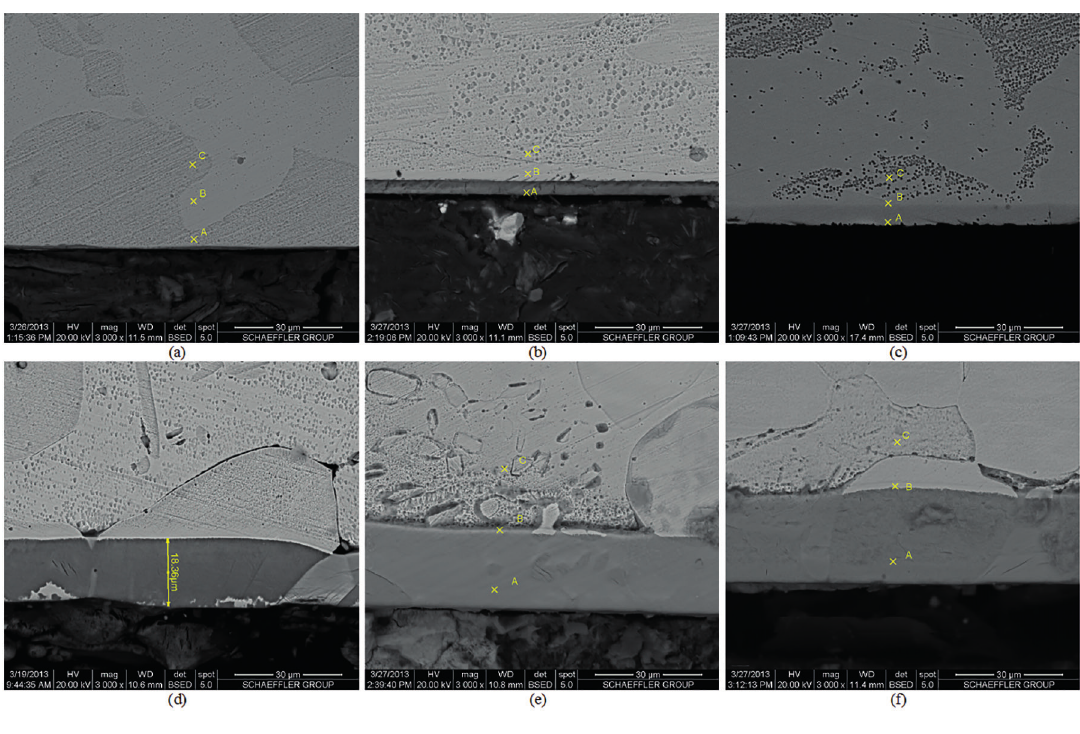
Figure 10: Micrography of the nitrided layers at different nitriding temperatures: (A) 350 °C, (B) 400 °C, (C) 450 °C, (D) 500 °C, (E) 550 °C and (F) 570 °C.